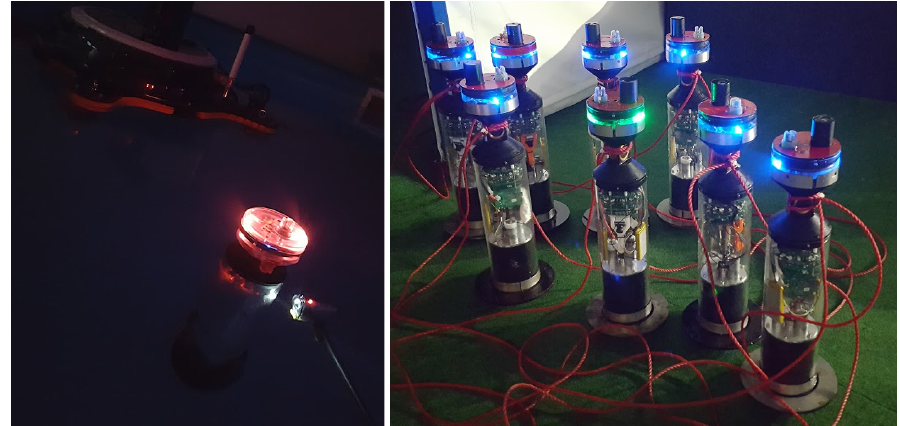
Figure 4. aMussel top cap comparison, initial version ( left ) and redesigned version ( right